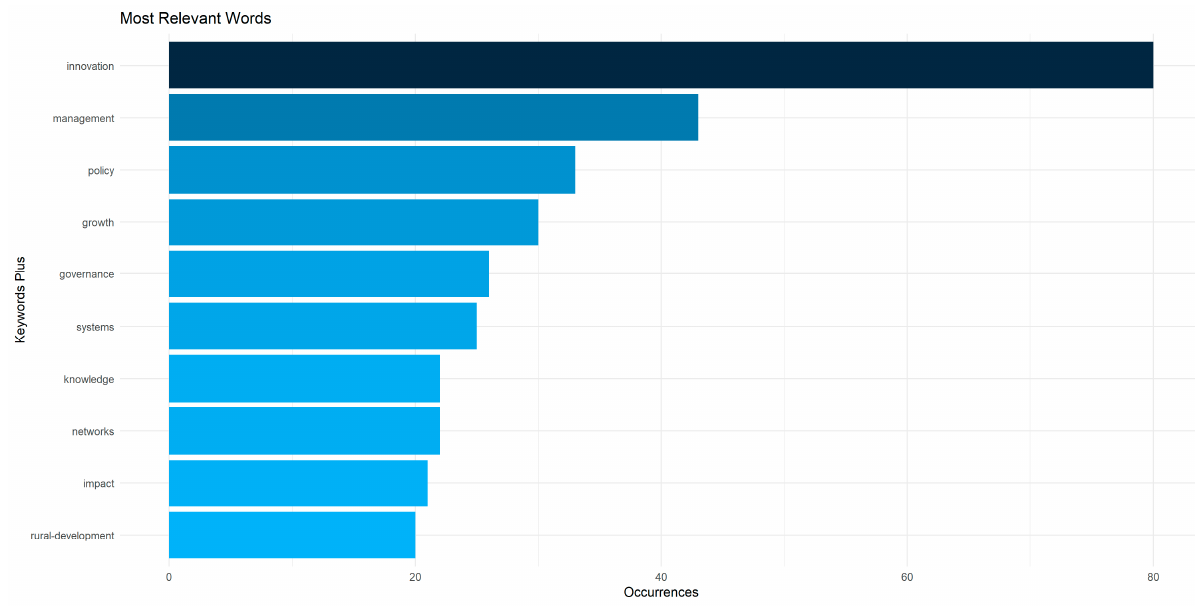
Figure 1. Τ hree-fields plot of research topics for each country and the recency of the papers that they cited.